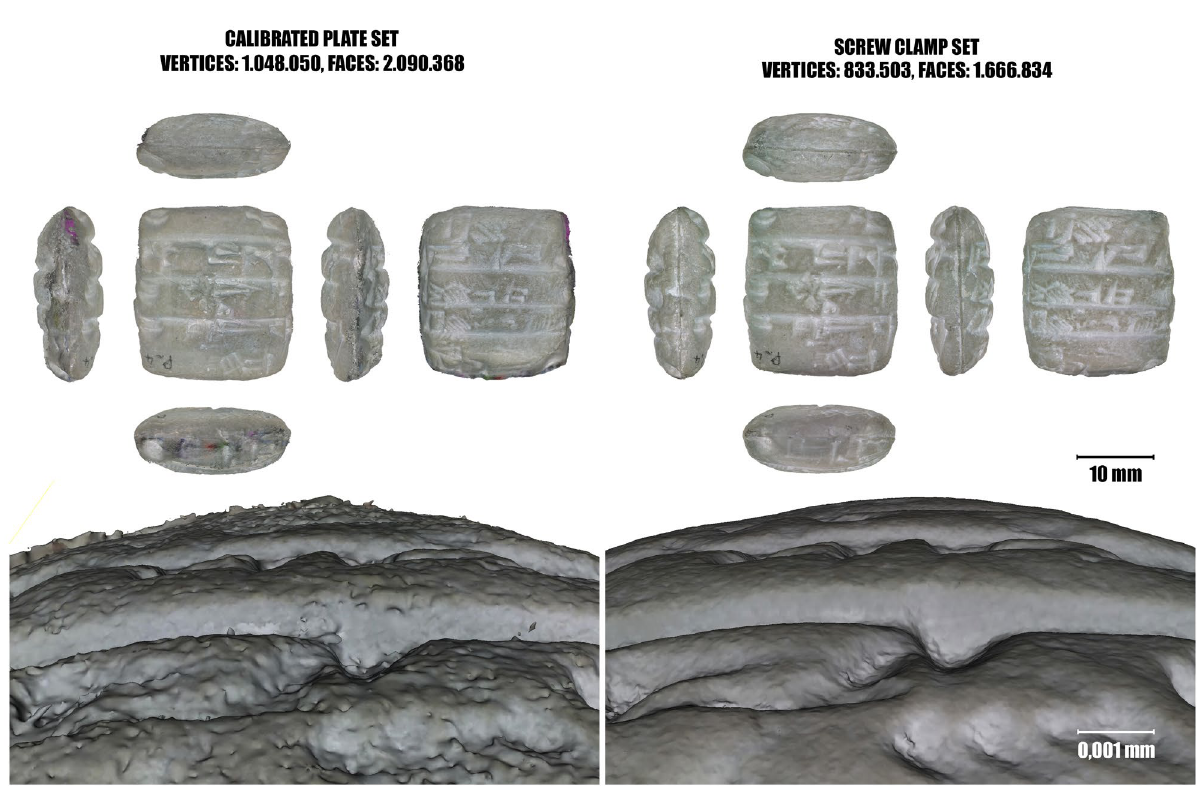
Figure 13 . Qualitative comparison of the models obtained using the calibrated plate (left) and the screw clamp as support